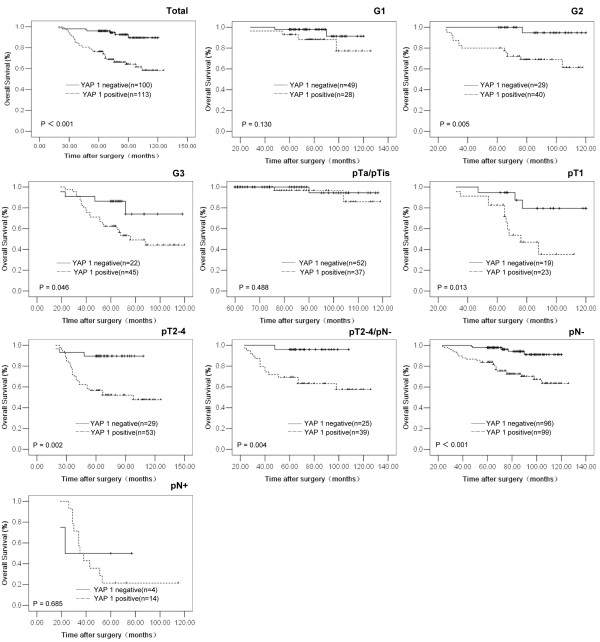
Kaplan-Meier survival analysis of YAP 1 expression in patients with UCB (log-rank test). Total, probability of survival of all patients with UCB: negative expression (solid line), n = 100; positive expression (dashed line), n = 113. G1, probability of survival of G1 patients with UCB: negative expression (solid line), n = 49; positive expression (dashed line), n = 28. G2, probability of survival of G2 patients with UCB: negative expression (solid line), n = 29; positive expression (dashed line), n = 40. G3, probability of survival of G3 patients with UCB: negative expression (solid line), n = 22; positive expression (dashed line), n = 45. pTa/pTis, probability of survival of pTa/pTis patients with UCB: negative expression (solid line), n = 52; positive expression (dashed line), n = 37. pT1, probability of survival of pT1 patients with UCB: negative expression (solid line), n = 19; positive expression (dashed line), n = 23. pT2-4, probability of survival of pT2-4 patients with UCB: negative expression (solid line), n = 29; positive expression (dashed line), n = 53. pT2-4/pN-, probability of survival of pT2-4/pN- patients with UCB: negative expression (solid line), n = 25; positive expression (dashed line), n = 39. pN-, probability of survival of pN- patients with UCB: ngative expression (solid line), n = 96; positive expression (dashed line), n = 99. pN+, probability of survival of pN+ patients with UCB: negative expression (solid line), n = 4; positive expression (dashed line), n = 14.